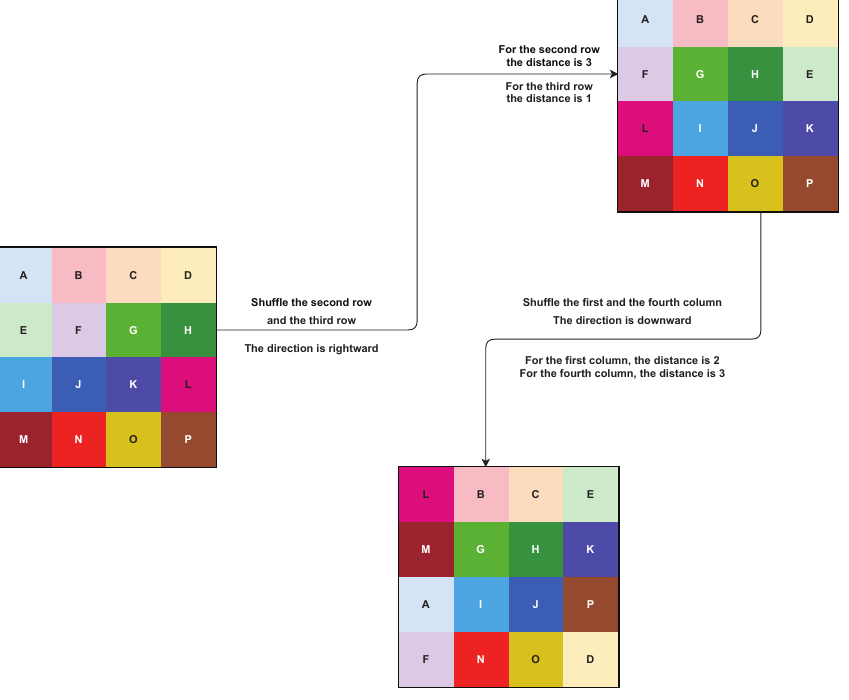
Figure 7. The example of the shuffling process based on Figure